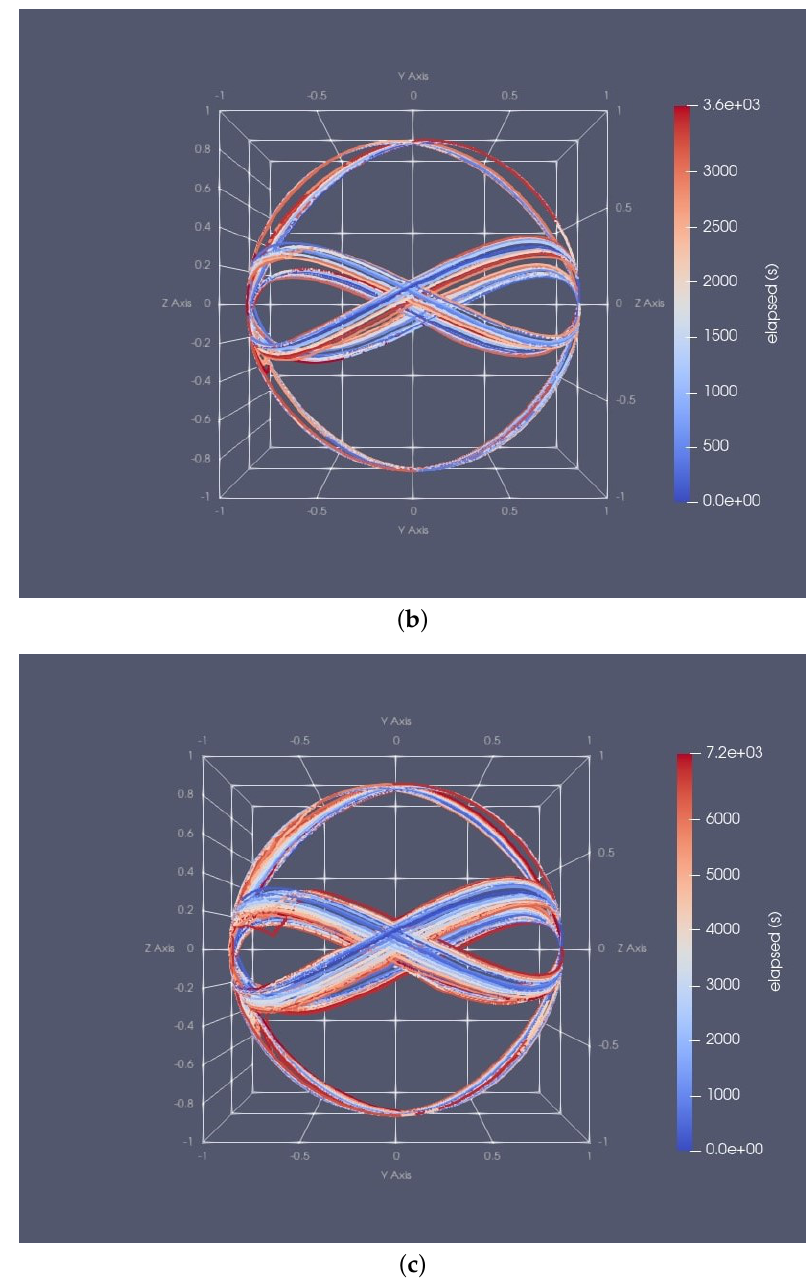
Figure A1. Motion trajectory of the gravity vector tip displayed on imaginary sphere (in 3D mode) for ( a ) 15 min of rotation; ( b ) 1 h of rotation; ( c ) 2 h of